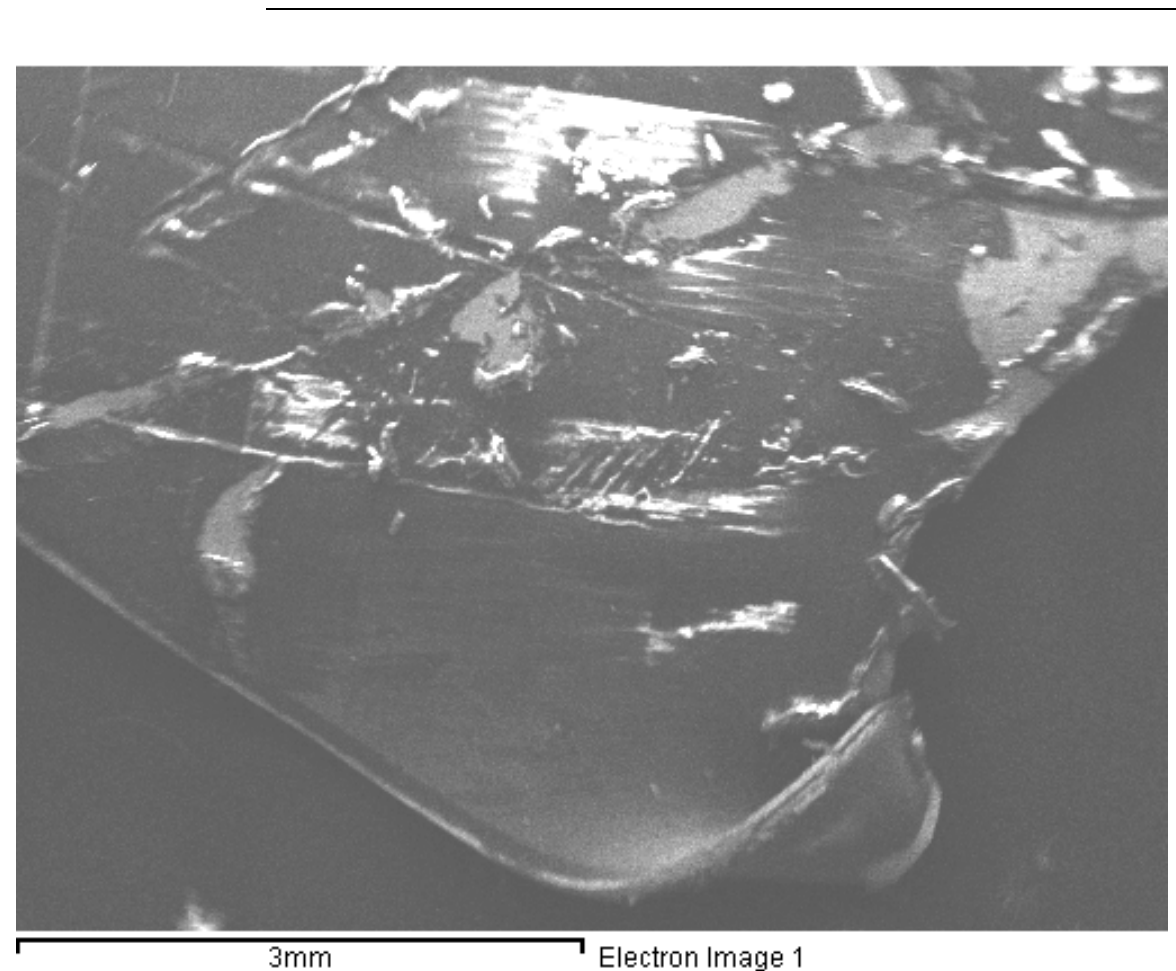
Figure 3. Example of a box fragment scanned by a Stereoscan 360” combined with an X Energy Dispersion Detector (SEM-EDX).